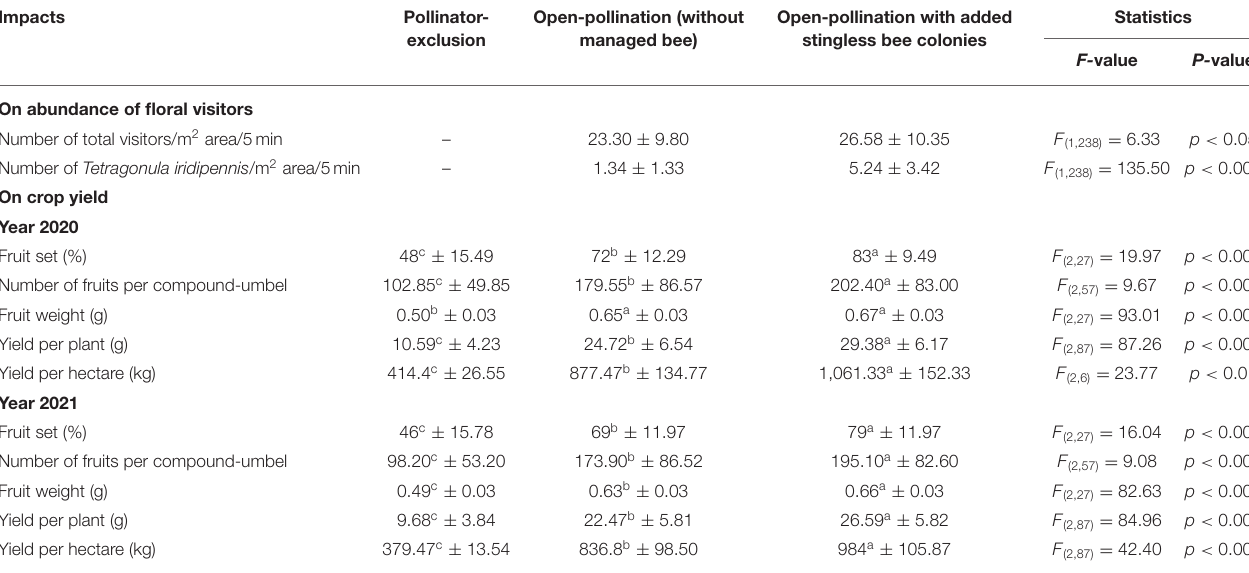
TABLE 6 | Impact of managed stingless bee colonies on floral visitors and crop yields of fennel.